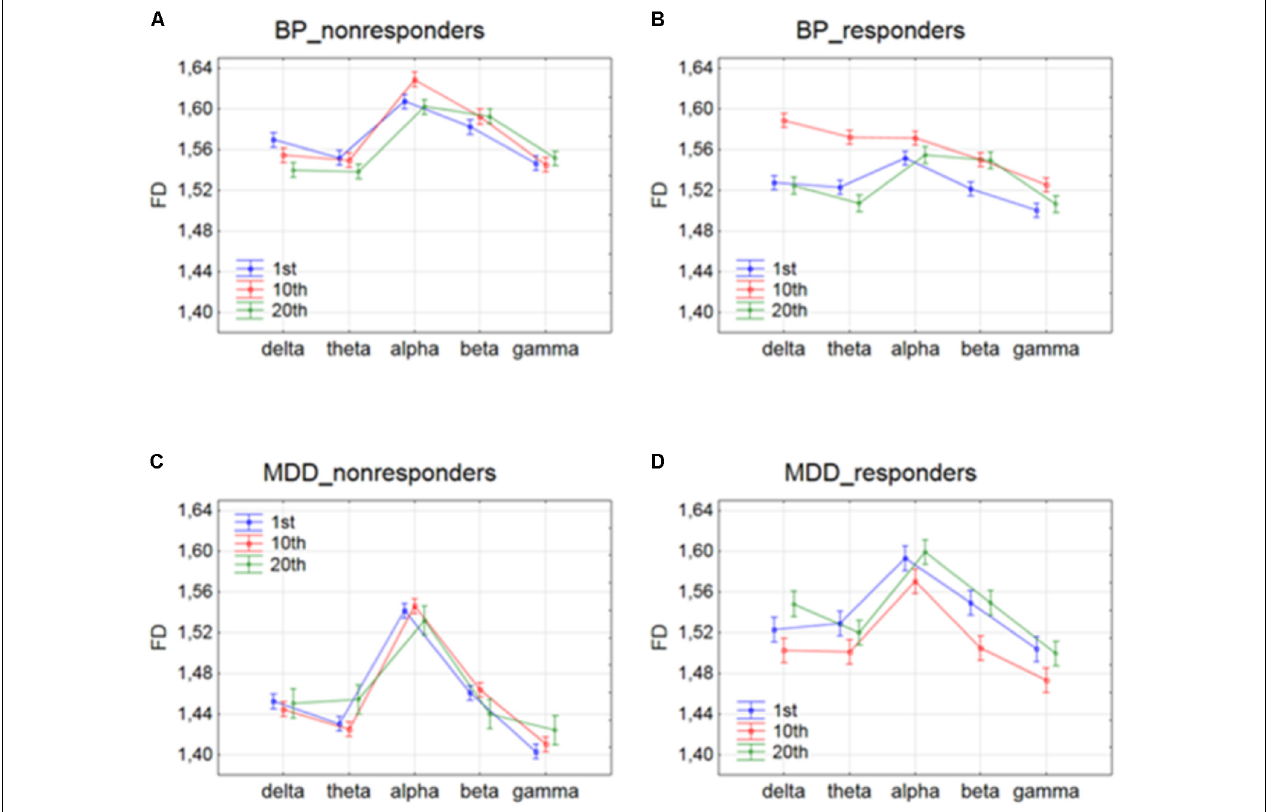
FIGURE 3 | Higuchi fractal dimension for BP_non-responders (A) , BP_responders (B) , MDD_non-responders (C) and MDD_responders (D) in five frequency bands. Comparison of results between 1st and 10th, 1st and 20th, and 10th and 20th session. The interaction between factors BAND and SESSION (both conditions were